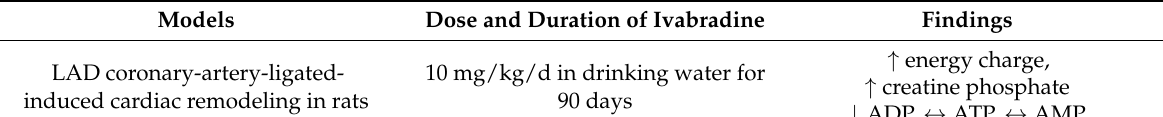
Table 6. Effects of ivabradine on apoptosis, autophagy, and biogenesis in animal studies. Models Findings